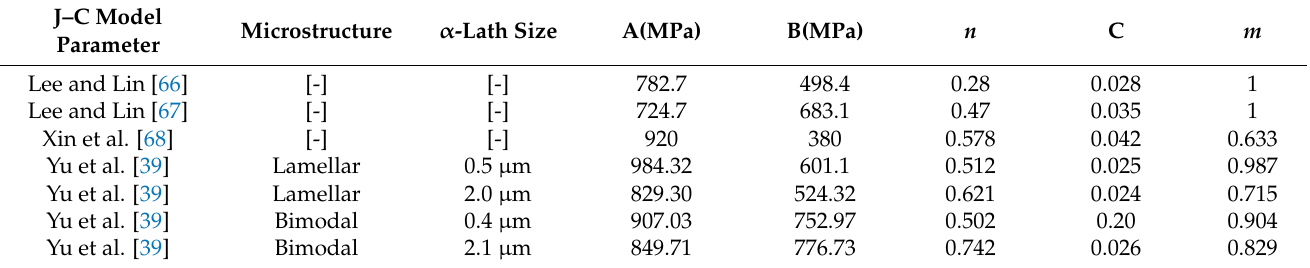
Table 6. A summary of J–C model parameters used to model the SHPB Ti6Al4V(ELI)